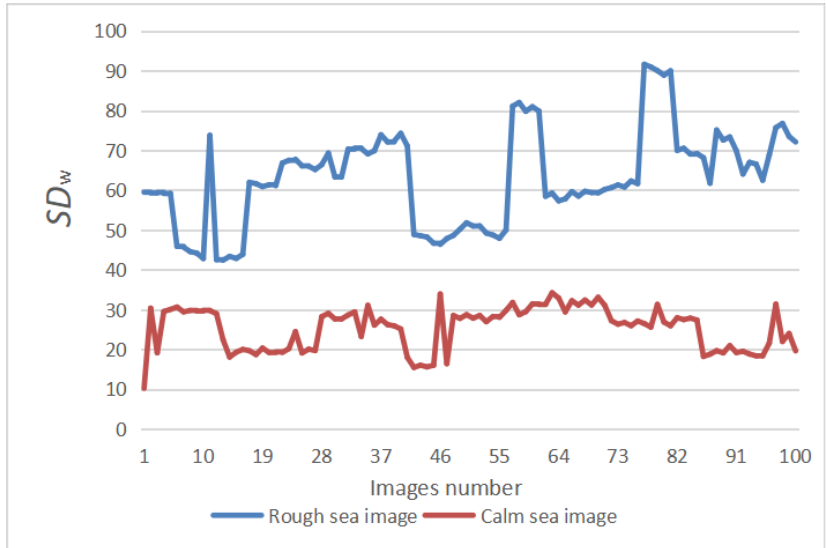
Figure 9. Local variance analysis of sea surface in the maritime image. The red curve represents the variation trend of the local variance of the calm sea image. The blue curve represents the variation trend of the local variance of the rough sea image.